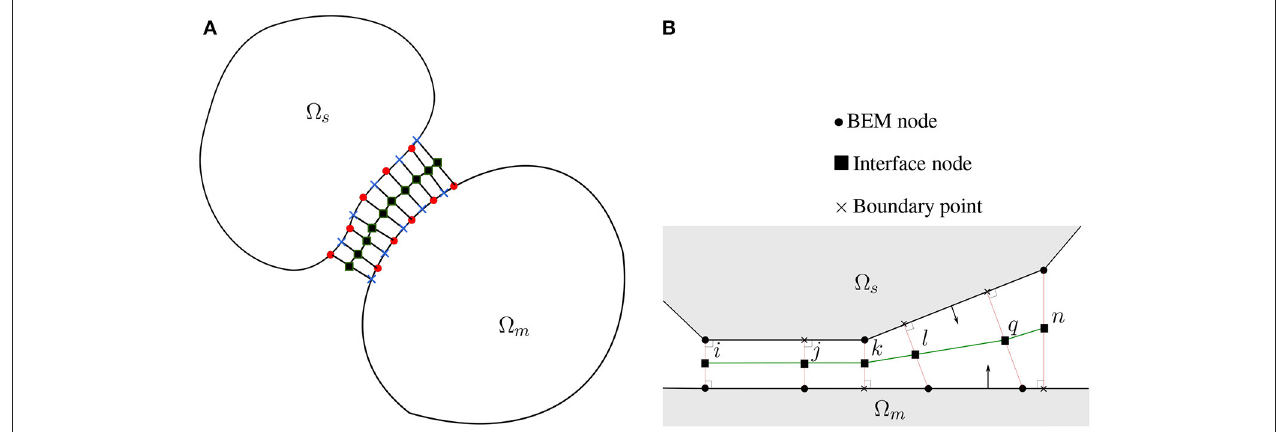
FIGURE 5 | (A) Interface elements constructed on an intermediate surface between two domains under possible contact, and (B) main and secondary elastic domains, corresponding nodes and interface elements.